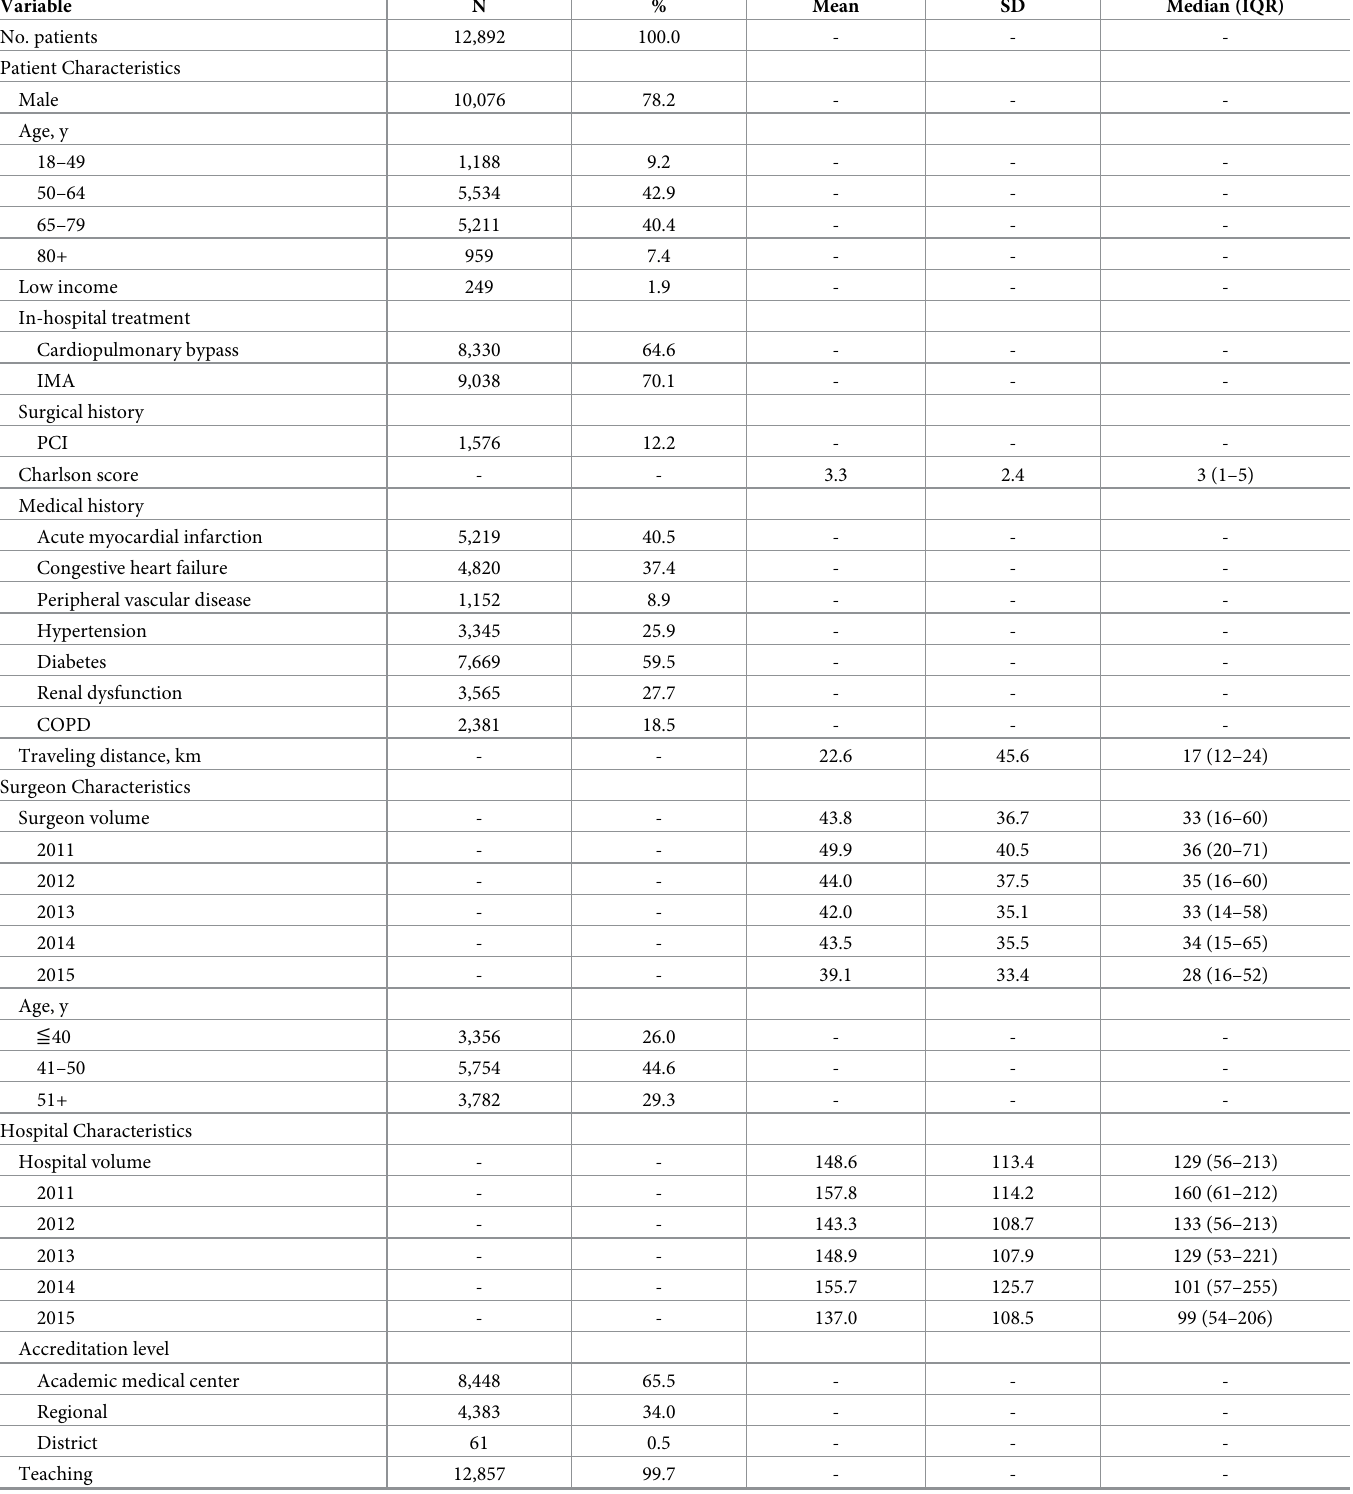
Table 1. Study population characteristics and unadjusted patient